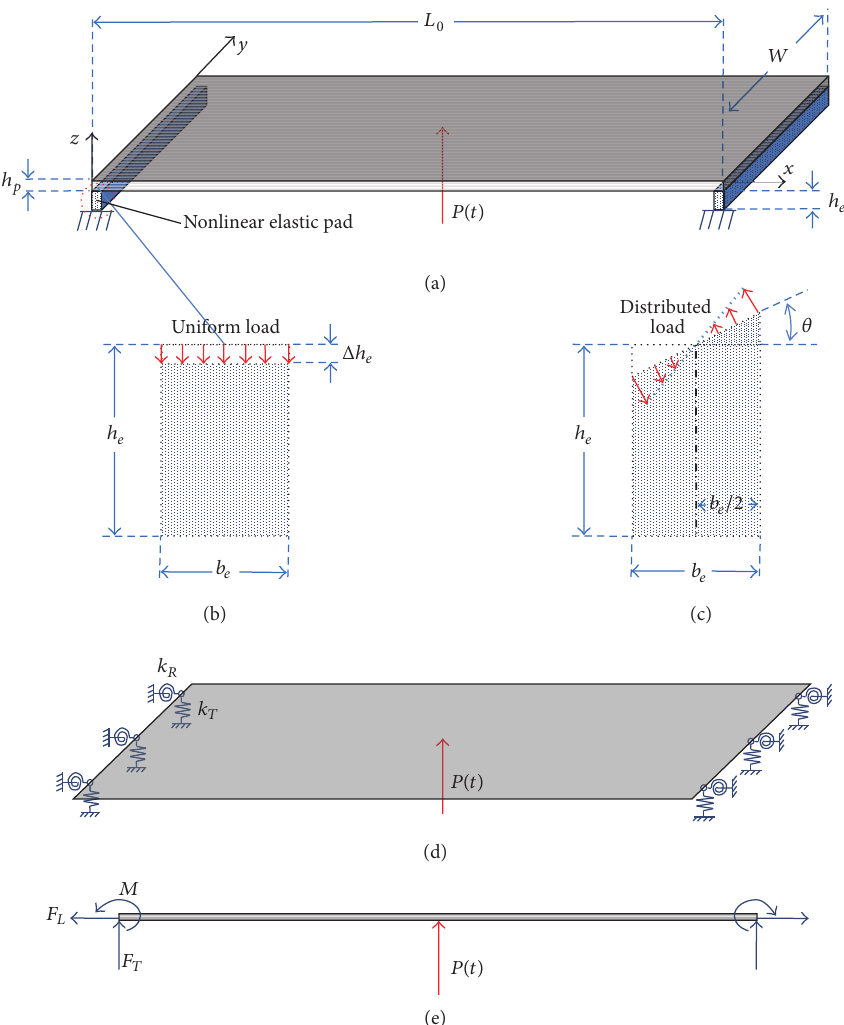
Figure 2: Mathematical model of plate supported by flexible strip-type pads at both short edges: (a) diagram of the system; (b) vertical deformation and force diagram; (c) bending deformation and force diagram; (d) flexible supports modeled by translational and rotational springs; (e) free body